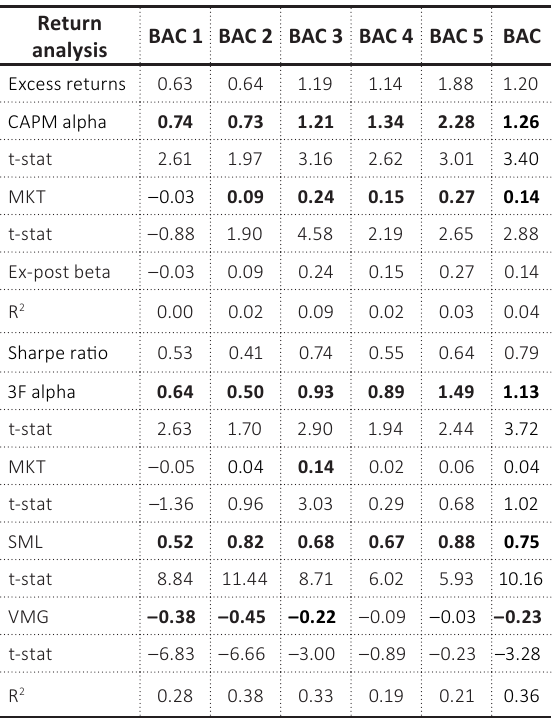
Source: Author’s